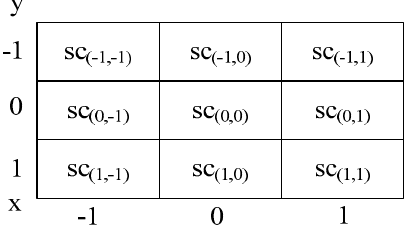
Figure 3. the flow of improved BRISK algorithm.